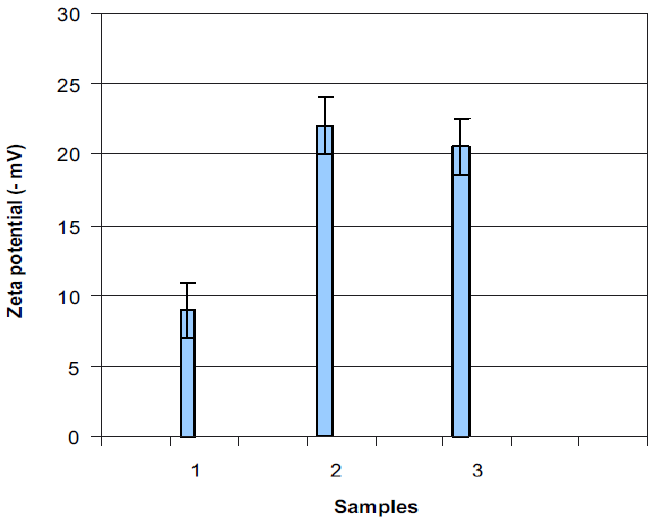
Figure 2. Zeta potential values of ( 1 ) untreated PVC; ( 2 ) plasma-treated PVC; and ( 3 ) 24 h after plasma treatment. The last sample is indicative of recovery (Reprinted with permission from [60]. Copyright 2007 Elsevier).